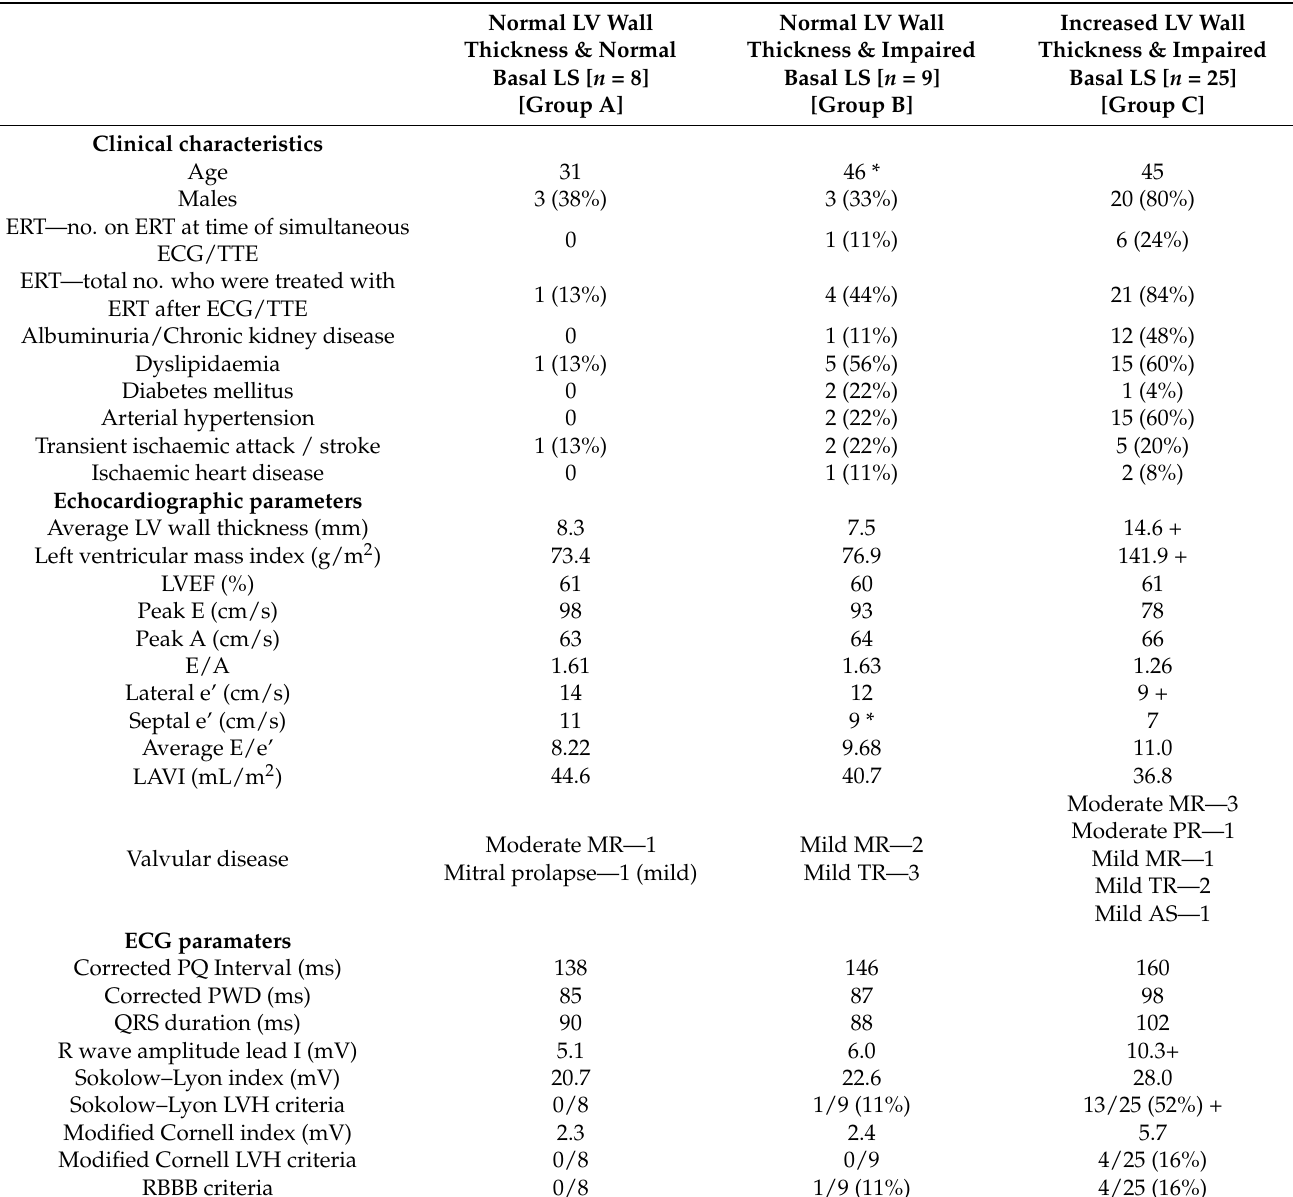
Table 2. Comparison of clinical, echocardiographic and electrocardiographic markers of FD patients with normal LV wall thickness and normal basal LS; normal LV wall thickness with impaired basal LS; and increased LV wall thickness and impaired basal